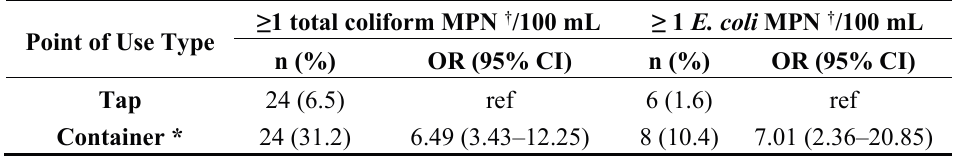
Table 4. Proportions and odds ratios of water samples with total coliforms and E. coli collected from taps and containers when water treatment systems were fully operational.